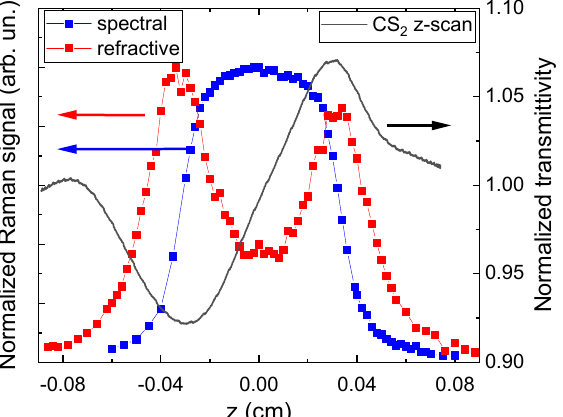
Figure 4. Dependence of the normalized intensity of the ISRS Raman mode at 173 cm –1 on the sample position. A CS 2 sample reference Z-scan trace to observe the correspondence between the positions of the RIKE signal maxima and those of the Z-scan trace peak and valley is also shown.